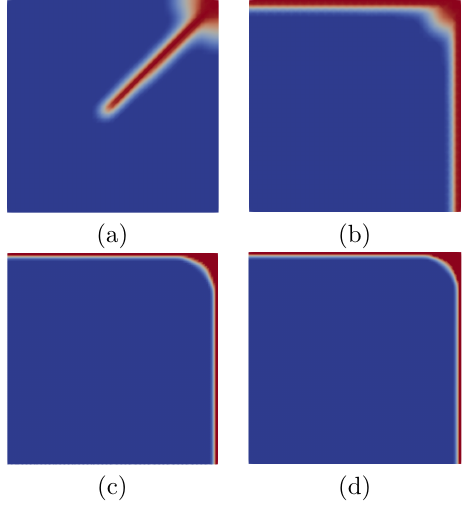
Figure 6. Damage distribution on meshes M1 (a, c) and M2 (b, d) for resolution 50 × 50 (a, b) and 100 × 100 (c, d). The blue represents intact material whereas red represents d close to 1.